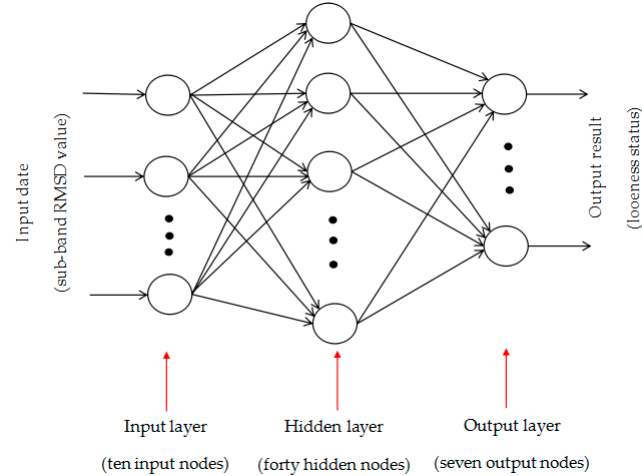
Figure 14. The structure of back propagation (BP) neural networks (10 × 40 × 7).